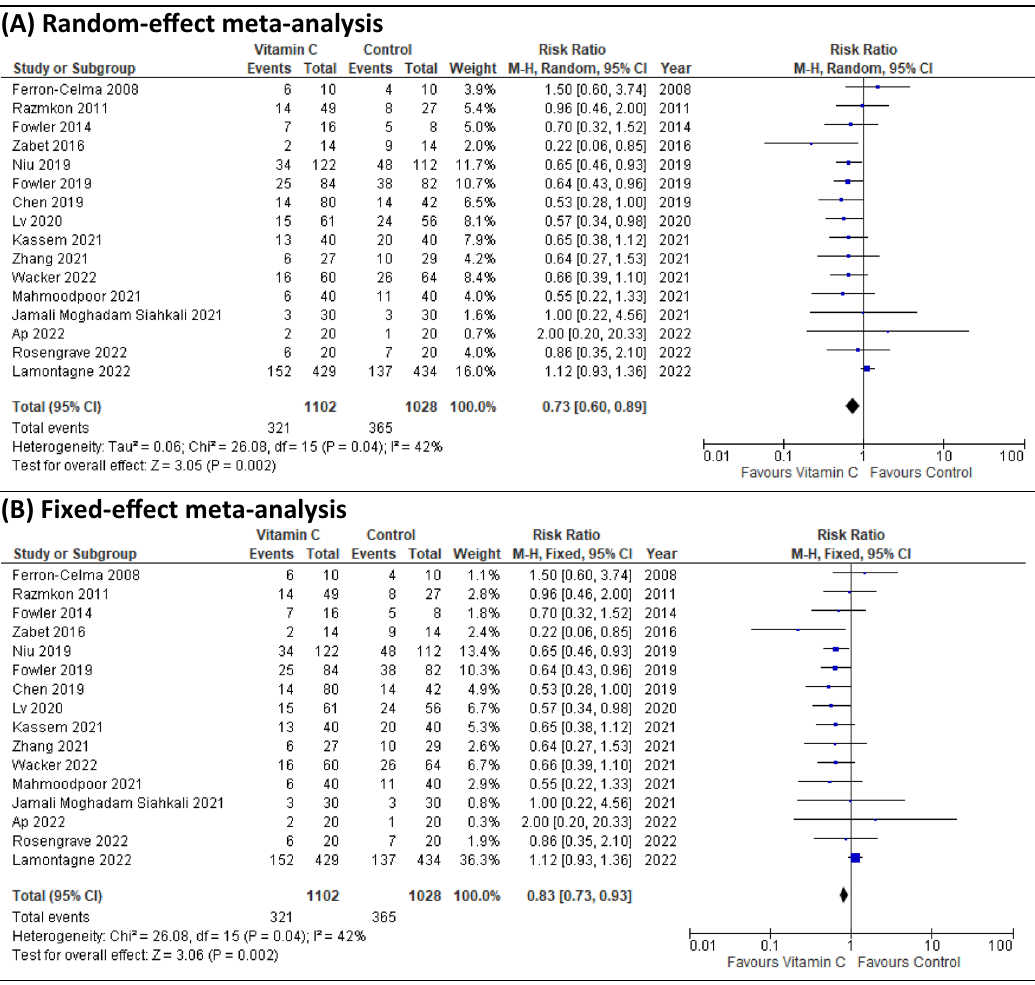
tional file 1: Figure S30). Ten studies reported the dura- tion of vasopressors but mean and SD were available in